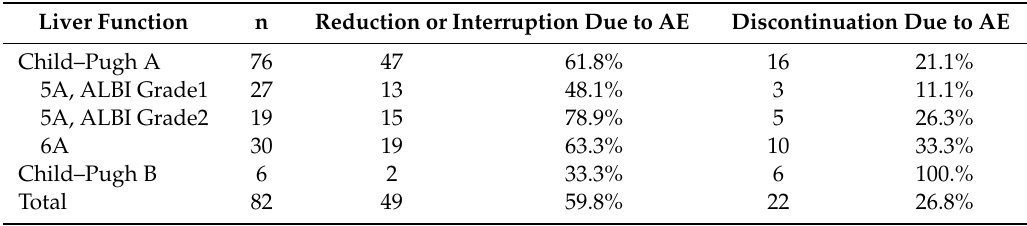
Table 3. Dose reduction, interruption, and discontinuation rate due to adverse